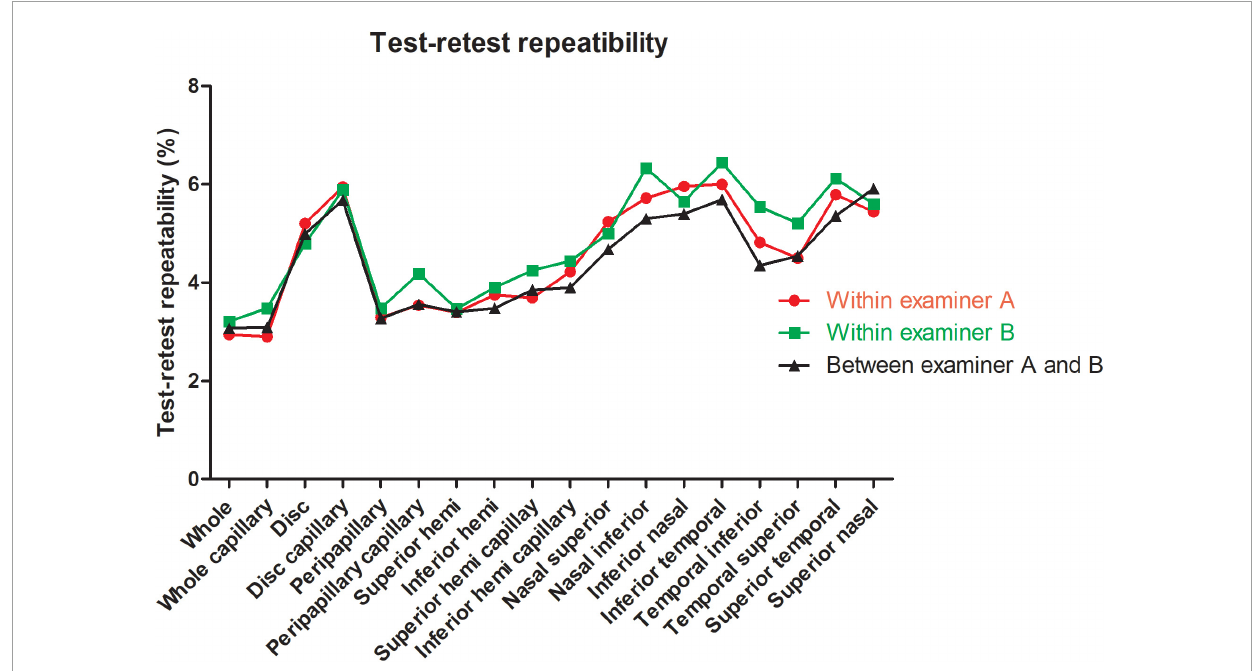
FIGURE3 Within-subject coefficient of papillary and peripapillary vascular density measurements intraexaminer and interexaminer.